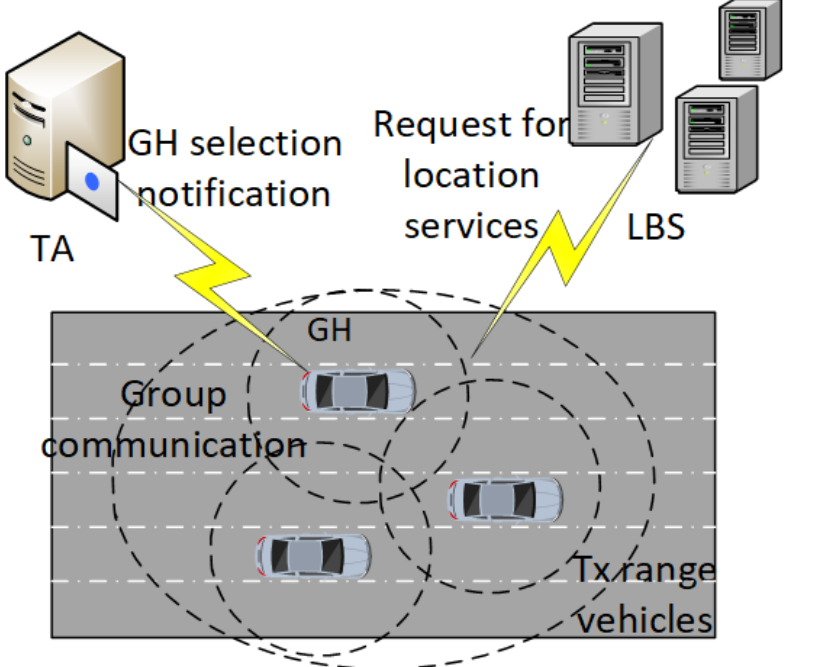
Figure 5. Selection of GH and group